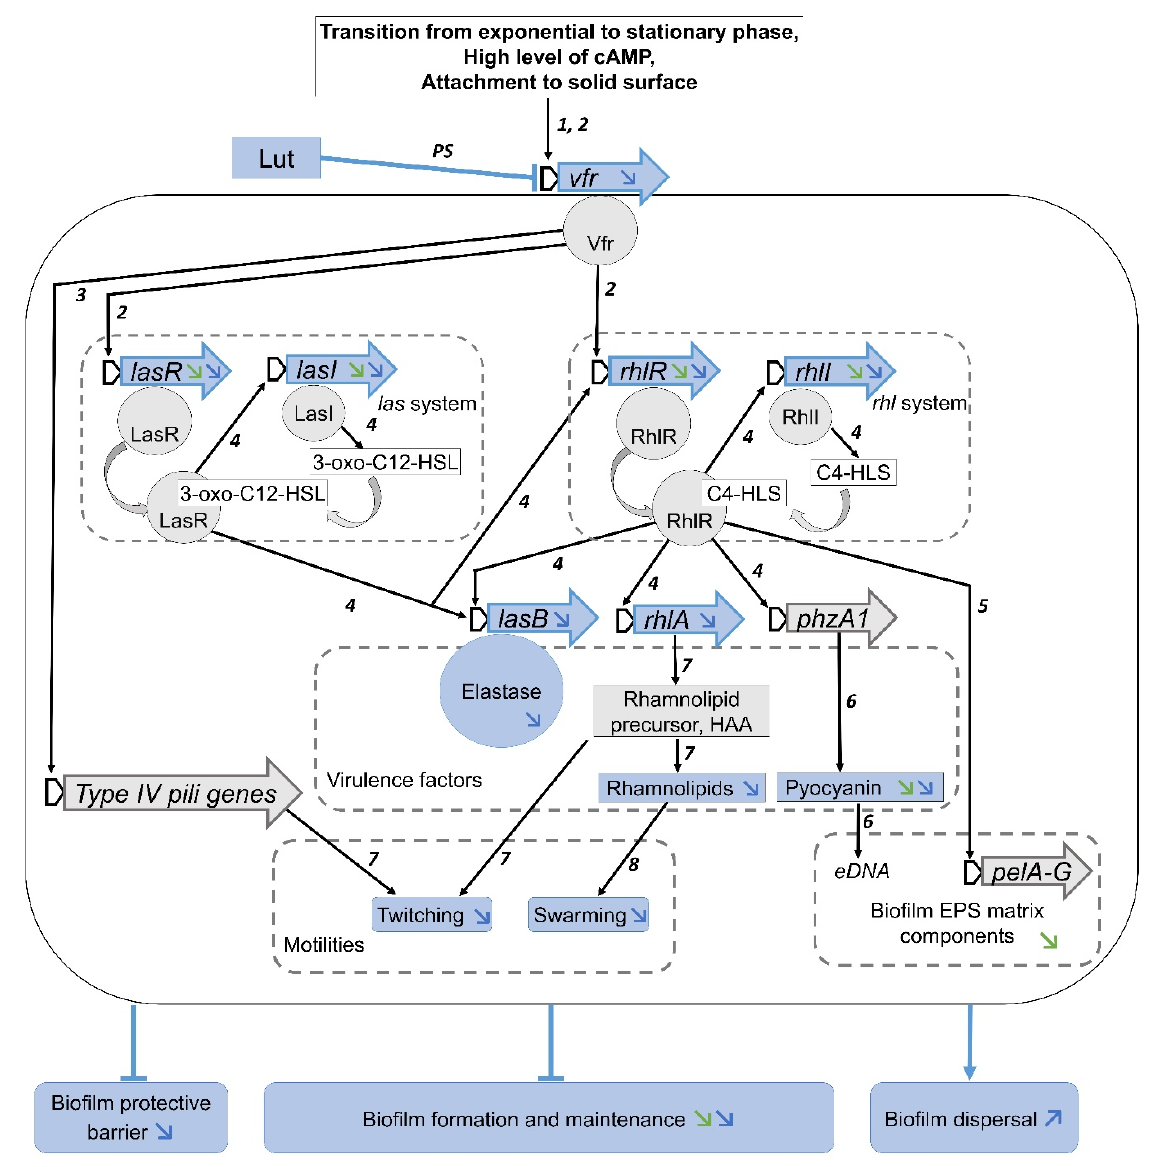
Figure 12. Proposed model of the mechanism underlying the target and inhibition cascade occurring in Lut-treated PAO1 to impact the Vfr transcriptional regulator, the regulation of QS-related genes and motility genes, and the biofilm development, maintenance and protective properties.